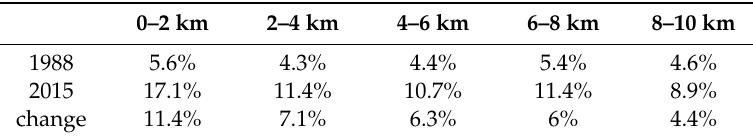
Table 8. Proportions of construction land in each